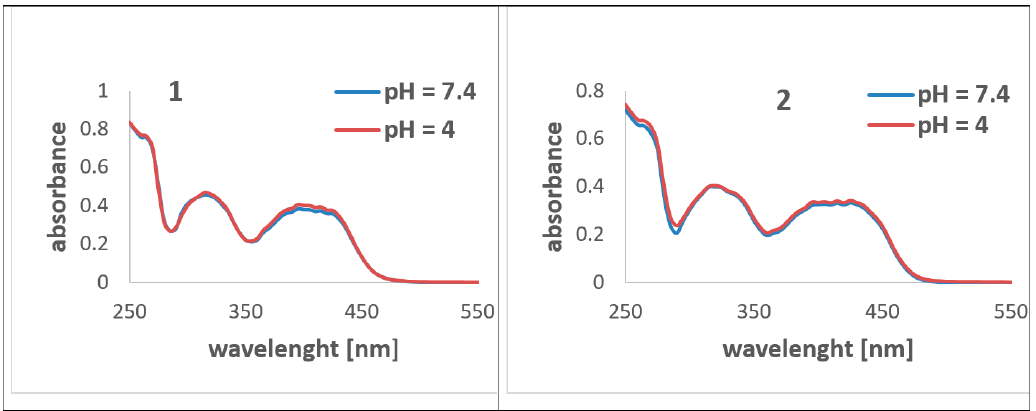
Figure 2. UV–Vis spectra of compounds 1 and 2 in aqueous methanol solution of di ff erent pH